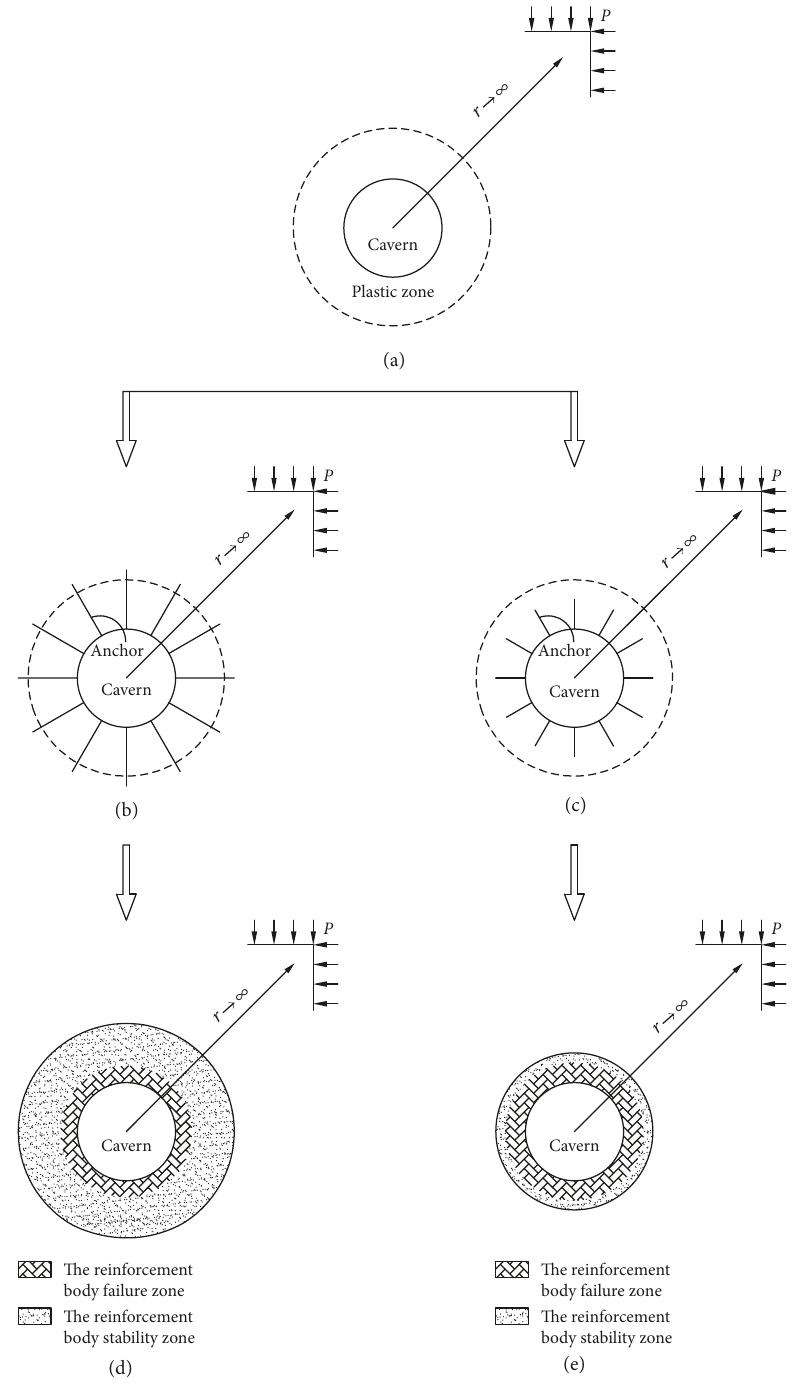
Figure 1: Surrounding rock damage evolution and anchor reinforcement: (a) plastic zone width after excavation of the cavern; (b) anchor length is greater than the plastic zone width; (c) anchor length is less than the plastic zone width; (d, e) the surrounding rock reinforcement body damage